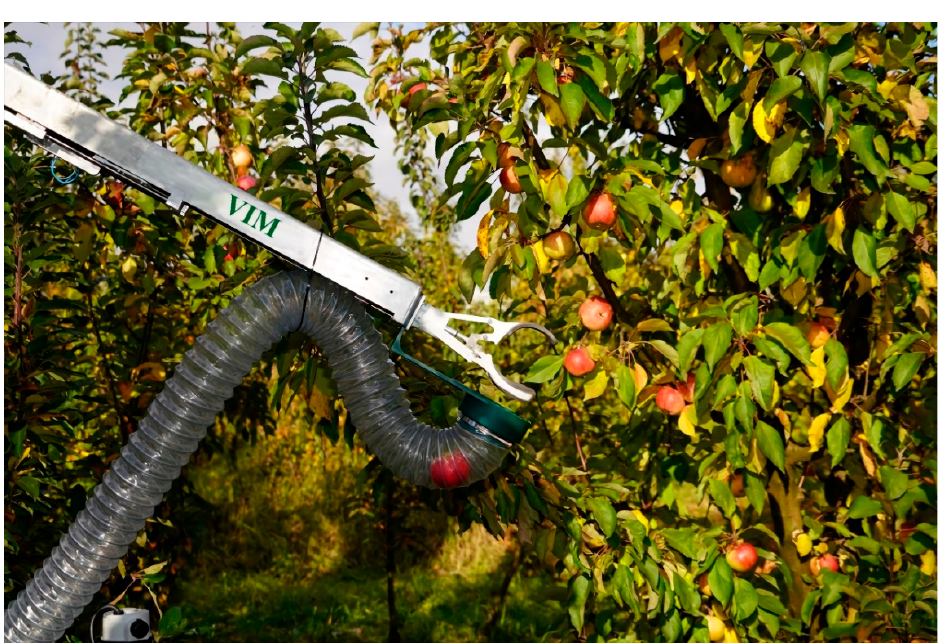
Figure 3. A robotic device mounted on a robotic platform for collecting apple